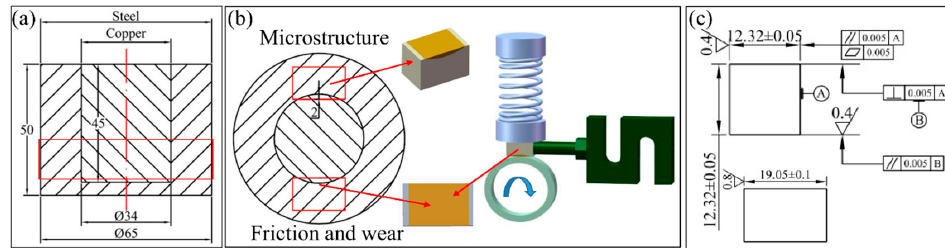
Figure 3. Bimetal samples size and sampling method. ( a ) Bimetal size before sampling; ( b ) microstructure and friction sampling location; and ( c ) size of the samples.